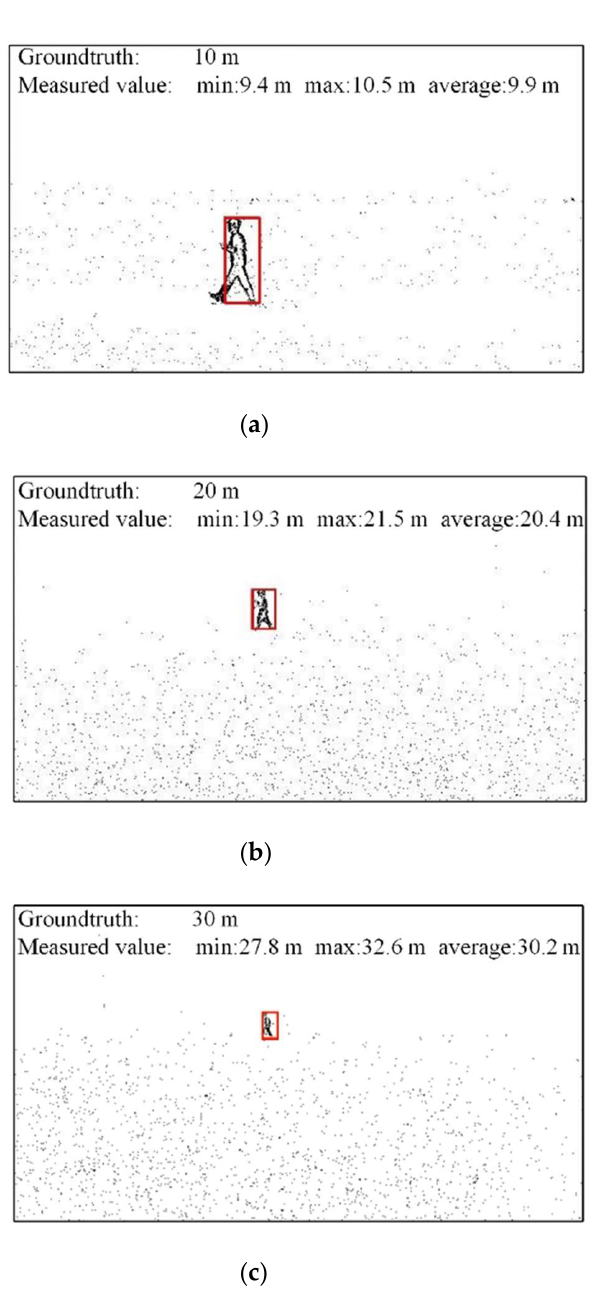
Figure 18. Results of a similar triangle distance measurement at different distances. ( a ) Groundtruth: 10 m, ( b ) Groundtruth: 20 m, ( c ) Groundtruth: 30 m. Table 7. Results of a similar triangle distance measurement method at different